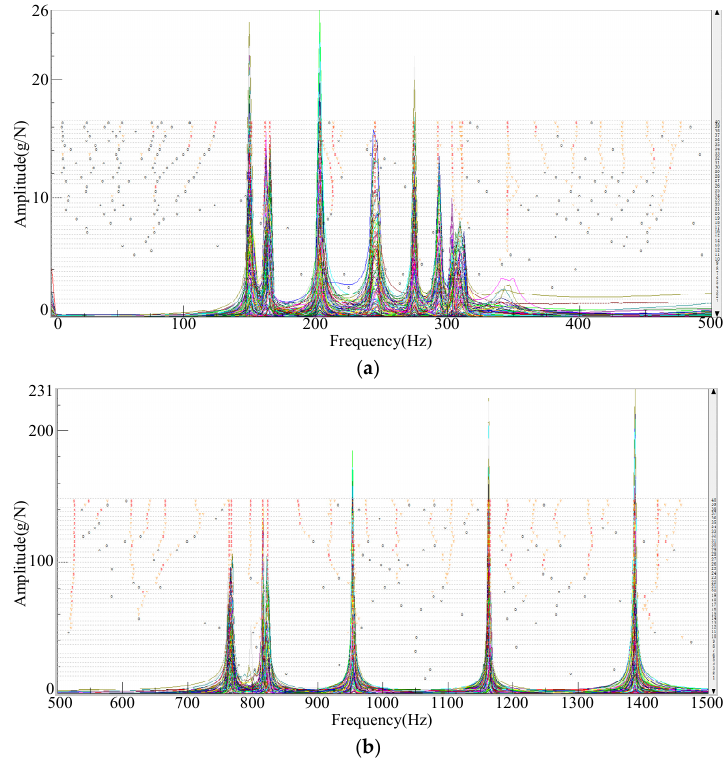
Figure 5. Stabilization diagrams within 1500 Hz. ( a ) Stabilization diagram ranging from 0 to 500 Hz; and ( b ) the stabilization diagram ranging from 500 to 1500 Hz. Table 3. Natural frequencies obtained by the Rayleigh ‐ Ritz method and experimental testing (Hz).